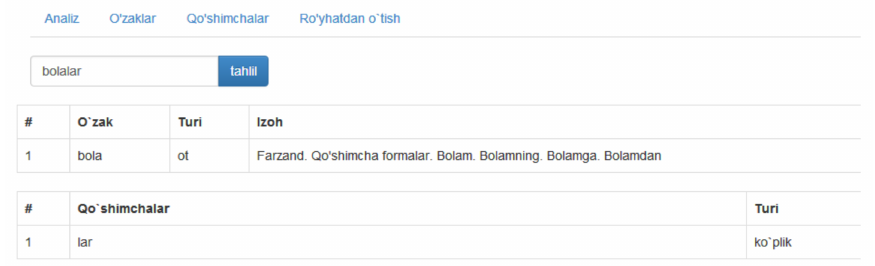
Figure 1. Detailed scheme of working process.